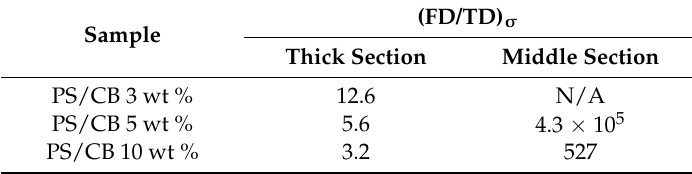
Table 1. The ratio of (FD/TD) σ for both the thick and middle sections of CB filled PS microparts.